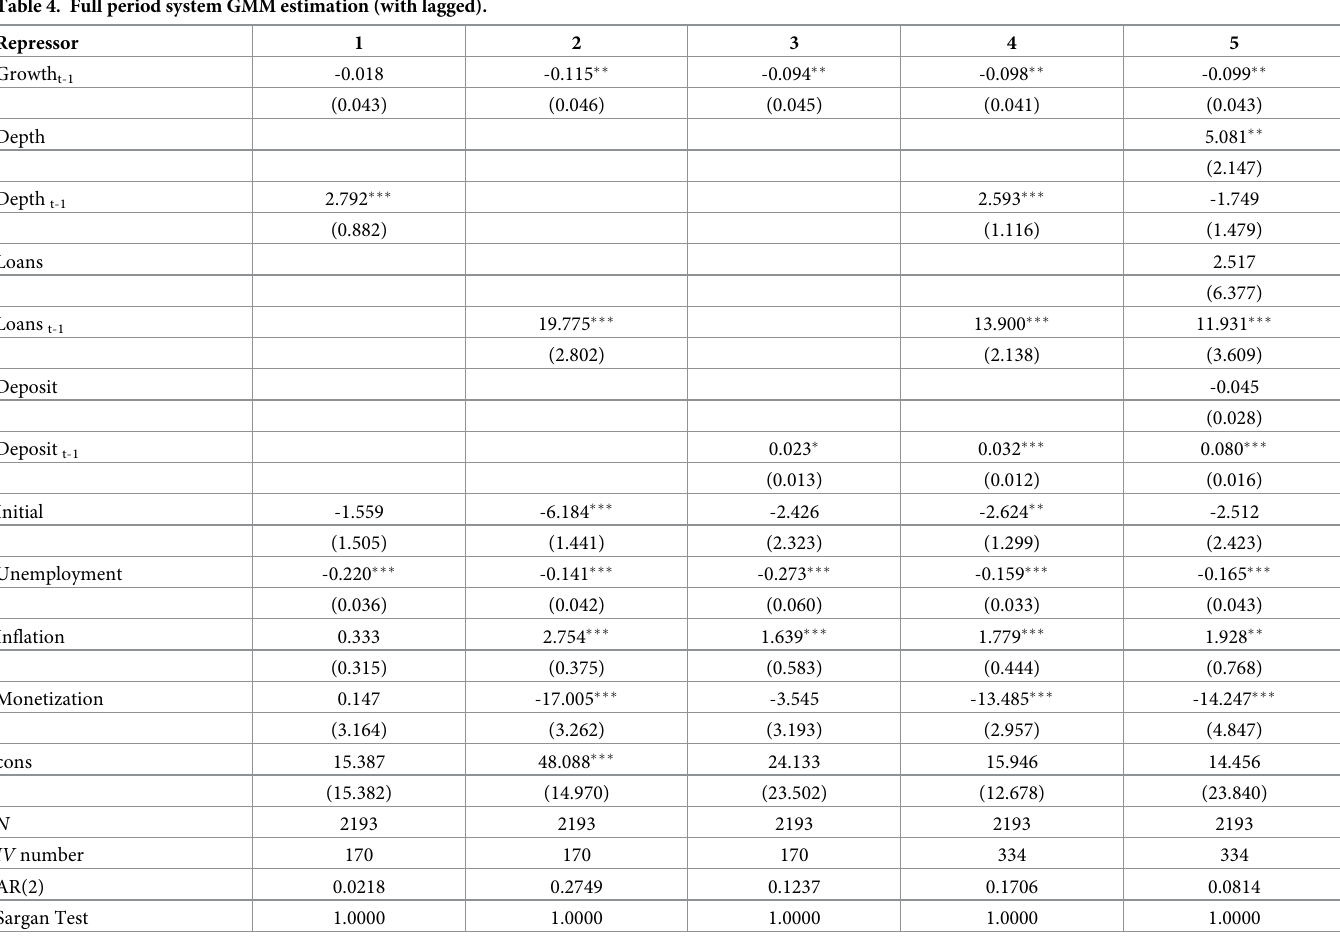
Table 4. Full period system GMM estimation (with